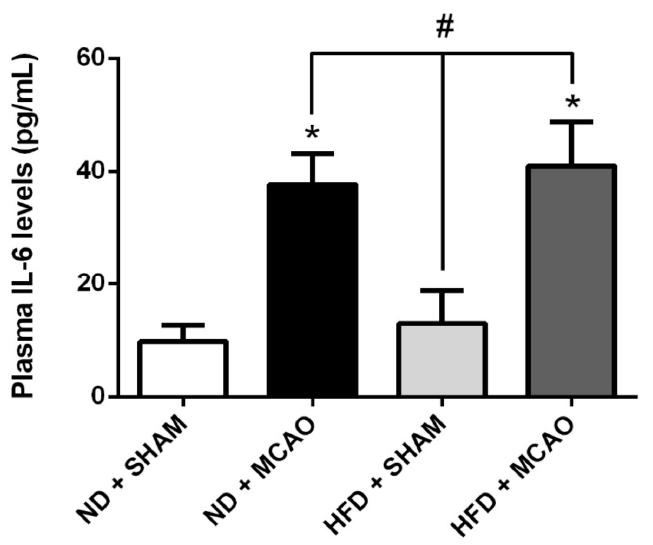
Figure 2. Metabolic deregulation illustrating metabolic syndrome. ( A ) Two months of HFD leads to an increase in plasma triglyceride levels. * p < 0.05 (ND + SHAM vs. HFD + SHAM) ** p < 0.001 (ND + MCAO vs. HFD + MCAO) ( n = 3 per group); ( B ) Correlation between triglyceridemia levels and body weight; ( C ) Plasma cholesterol levels are higher in HFD groups relative to ND groups; * p < 0.05 (ND + SHAM vs. HFD + SHAM) ** p < 0.001 (ND + MCAO vs. HFD + MCAO) ( n = 3 per group); ( D ) Correlation between cholesterolemia levels and body weight; ( E ) HFD increases significantly leptin plasma levels relative to ND; *** p < 0.0001 (ND + SHAM vs. HFD + SHAM and ND + MCAO vs. HFD + MCAO) ( n = 3 per group); ( F ) Positive correlation between leptinemia and body weight.